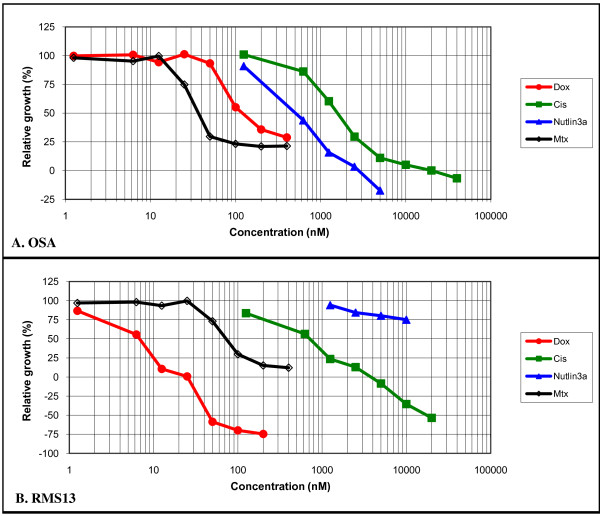
Representative growth inhibition curves for OSA (A) and RMS13 (B) after Nutlin-3a, Doxorubicin, Cisplatin and Methotrexate exposures. Exponentially growing cancer cells with TP53Wt(OSA) or TP53Mut(RMS13) were incubated with a range of drug concentrations for 120 h. Relative growth was measured by the SRB assay.